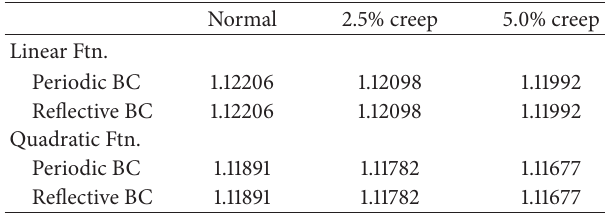
Table 2: Multiplication factors of the TRIAINA-P1 code.